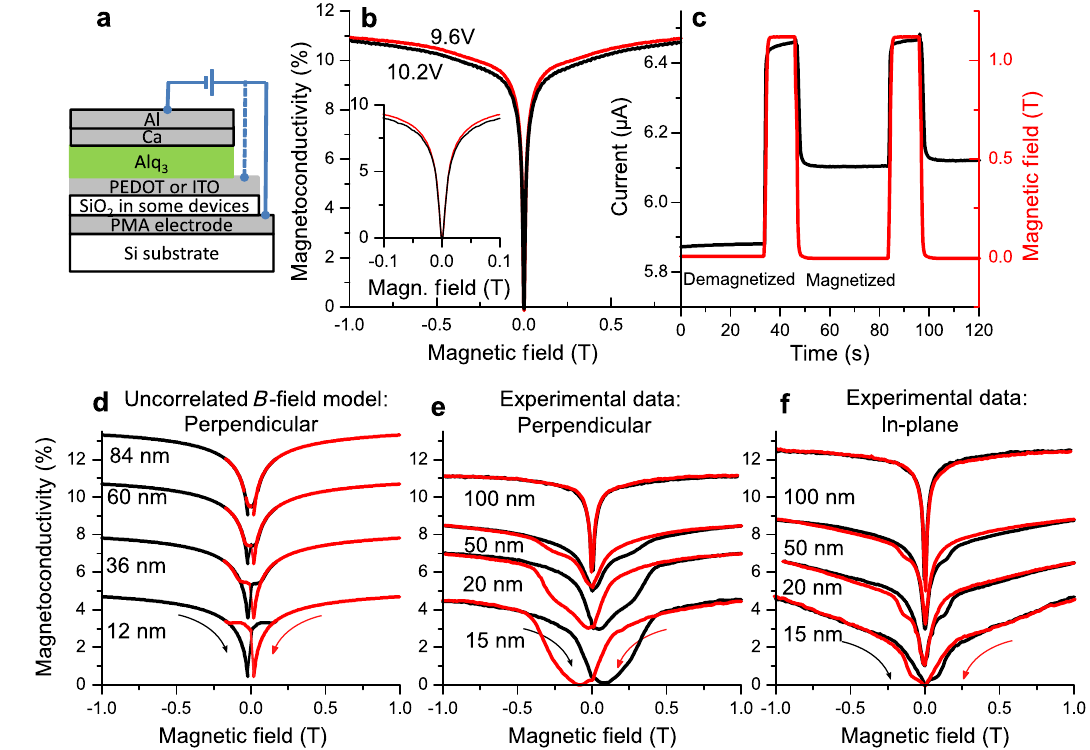
FIG. 2. Magnetoresistance in organic semiconductor devices. (a) Device schematic. (b) Organic magnetoconductivity caused by random hyperfine fields in a device using two nonmagnetic electrodes. (c) Hysteretic conductance in an organic semiconductor semi– spin valve with a bottom ferromagnetic electrode. Initially, the electrode is in a demagnetized state. At time 35 s, a magnetizing magnetic field is applied (red curve). Even after the magnetizing magnetic field is removed, the device conductivity (black curve) remains several percent above its original value. (d) Expectation for devices based on an uncorrelated B -field model, described in Appendix B, which considers the fringe fields to modify the local conductivity through the nonmagnetic organic magnetoresistance in (b). (e),(f) Dependence of the magnetoconductivity on the thickness of the PEDOT spacer layer between the ferromagnetic electrode and the magnetoresistive organic semiconductor for (e) perpendicular and (f) in-plane applied magnetic fields, respectively. The black curves are for sweeps from large negative fields to large positive fields, and the red curves for the return sweep. The numbers assigned specify the PEDOT spacer-layer thickness. (The data have been offset along the y axis for added clarity.) The applied voltage biases are 4.5, 7, 7.2, and 7.5 V for the 15, 20, 50, and 100 nm devices, respectively. At small spacer-layer thickness, the magnetoconductivity is dominated by the hysteretic fringe-field-induced magnetoconductance, whereas for large spacer-layer thickness, we recover the hyperfine-induced magnetoconductance shown in